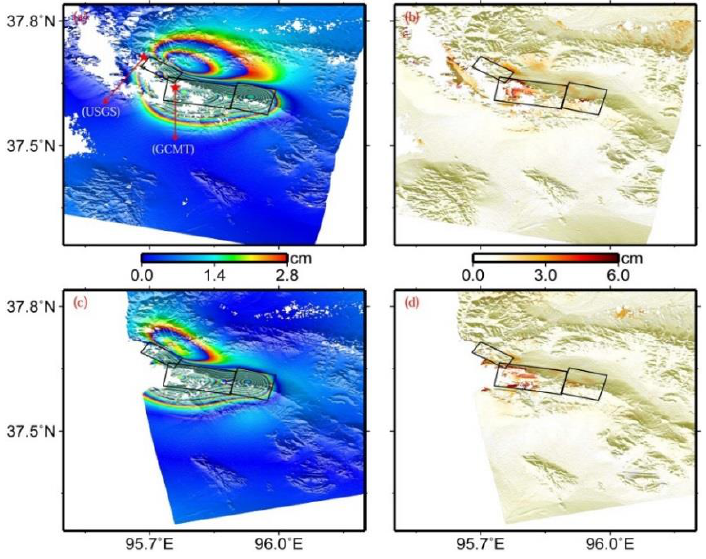
Figure 7. Modeled ( a ) and residual ( b ) interferograms predicted by the slip